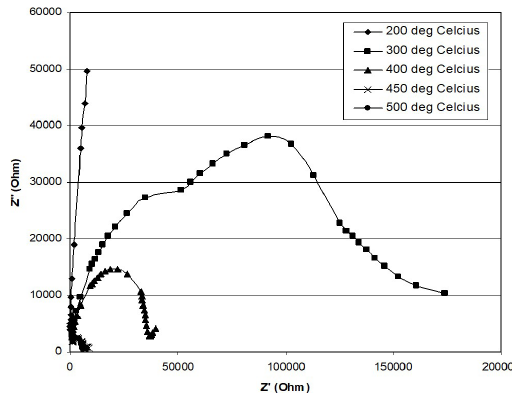
Figure 9. Complex impedance measured at 200,300,400,450 and 500 0 C in air of CSZ specimen containing 15 mol % CaO.